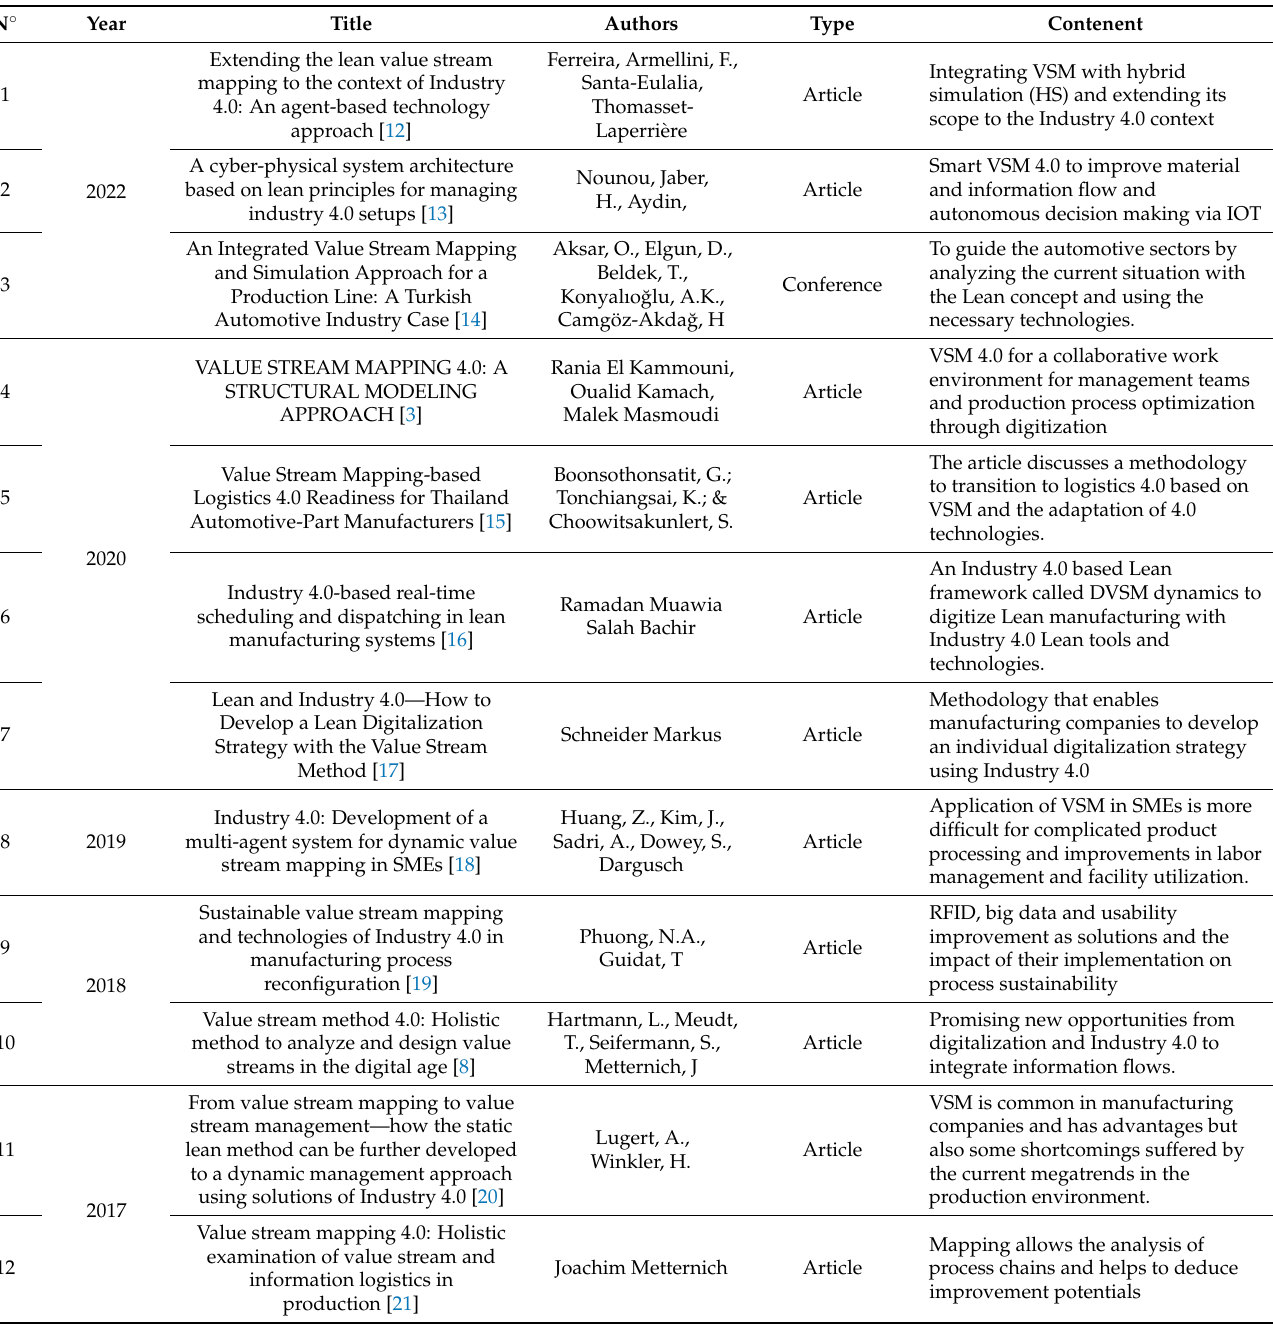
Table 1. Literature review from 2015 to